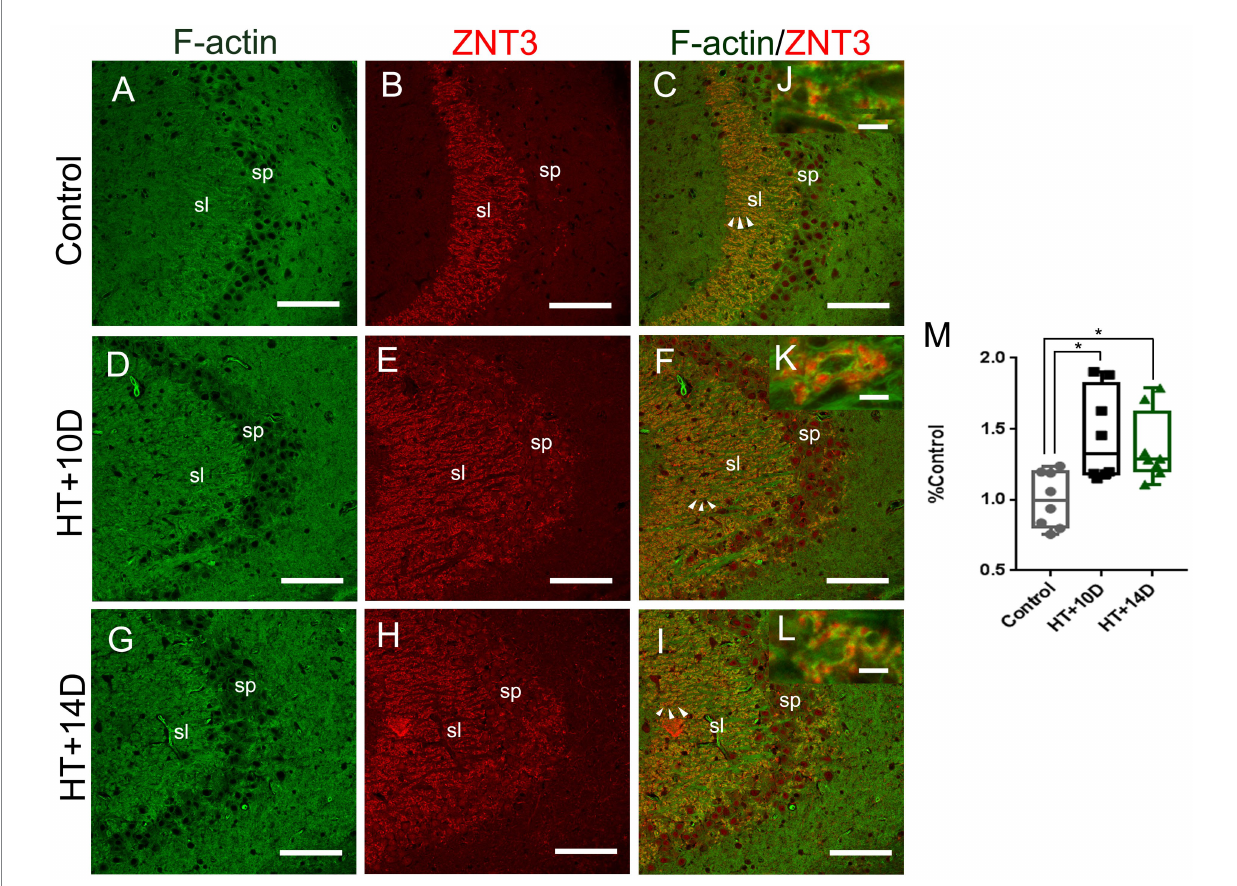
FIGURE 4 Relative localization of F-actin and ZNT3 in Hippocampal Subfield CA3. Scale bars: (A–I) 100 μ m; (J–L) 5 μ m. Representative images (A,D,G) (green) show F-actin puncta in the subfields of stratum lucidum of CA3 in different groups. Images (B,E,H) (red) show ZNT3 granules in the same region. Images (C,F,I) are merged from (A,B,D,E,G,H) , respectively. (J–L) Are magnified images for arrow areas. It shows that the localization of F-actin is roughly the same as that of ZNT3 in CA3 stratum lucidum. The fluorescence intensity of ZNT3 is dramatically increased (E,H) in the area where F-actin intensity is increased (D,G) . The enlarged images (J–L) show puncta of F-actin and ZNT3 are located in close proximity (yellow) indicating their co- localization. Statistical analysis of overlapping area of F-actin and ZNT3 (yellow) shows a significant increase in both HT+ groups (M) (* p 1 = 0.03, * p 2 = 0.02, n = 8 per